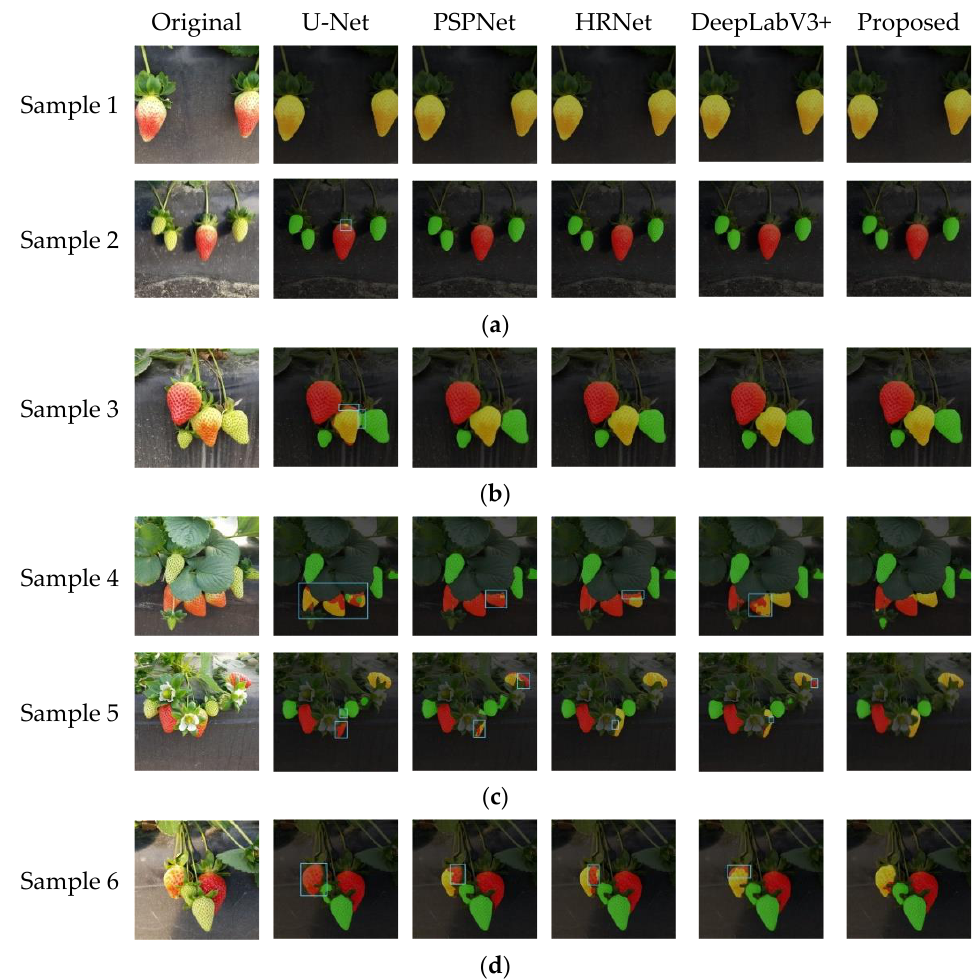
Figure 10. The effect of different strawberry image segmentation models. ( a ) No shade; ( b ) fruit adhesion; ( c ) leaf shading; ( d ) fruit stacking.